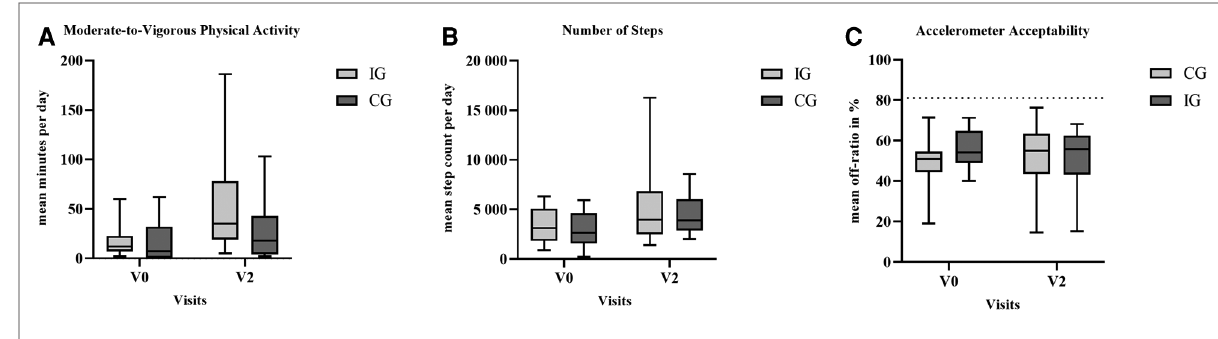
FIGURE 3 Between-group differences at the baseline (V0) and Visit 2 regarding the outcome ( A ) moderate-to-vigorous physical activity; ( B ) physical activity amplitude, and ( C ) accelerometer acceptability. The dashed line at 81% off-ratio represents the minimum accelerometer wearing time of 4 days with 8 h/day. Note: Whiskers represent the minimum and maximum of the